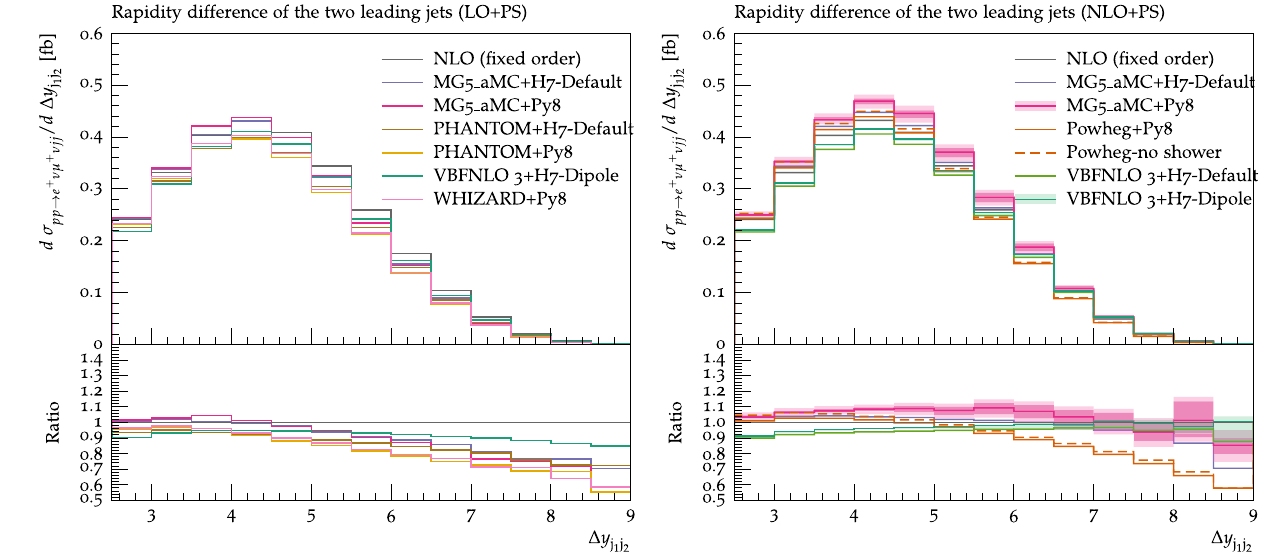
Fig. 15 Differential distribution in the rapidity separation of the two tagging jets from predictions matched to parton showers, at LO (left) or NLO (right) accuracy (upper plot), compared with the fixed-NLO result computed with VBFNLO (lower plot). At NLO+PS accuracy, for VBFNLO + Herwig7- Dipole , the three-point scale uncertainties are